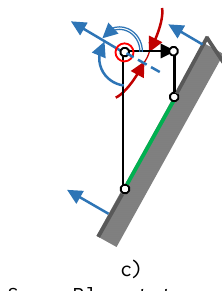
Figure 8. Selection of the transformation direction according to the Sweep Plane strategy.